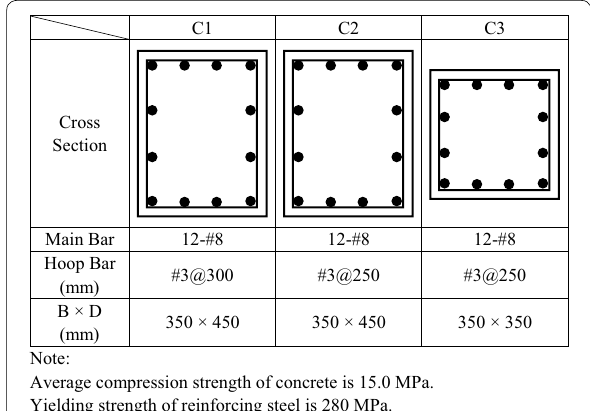
Fig. 23 Detailed information needed in the pushover analysis.